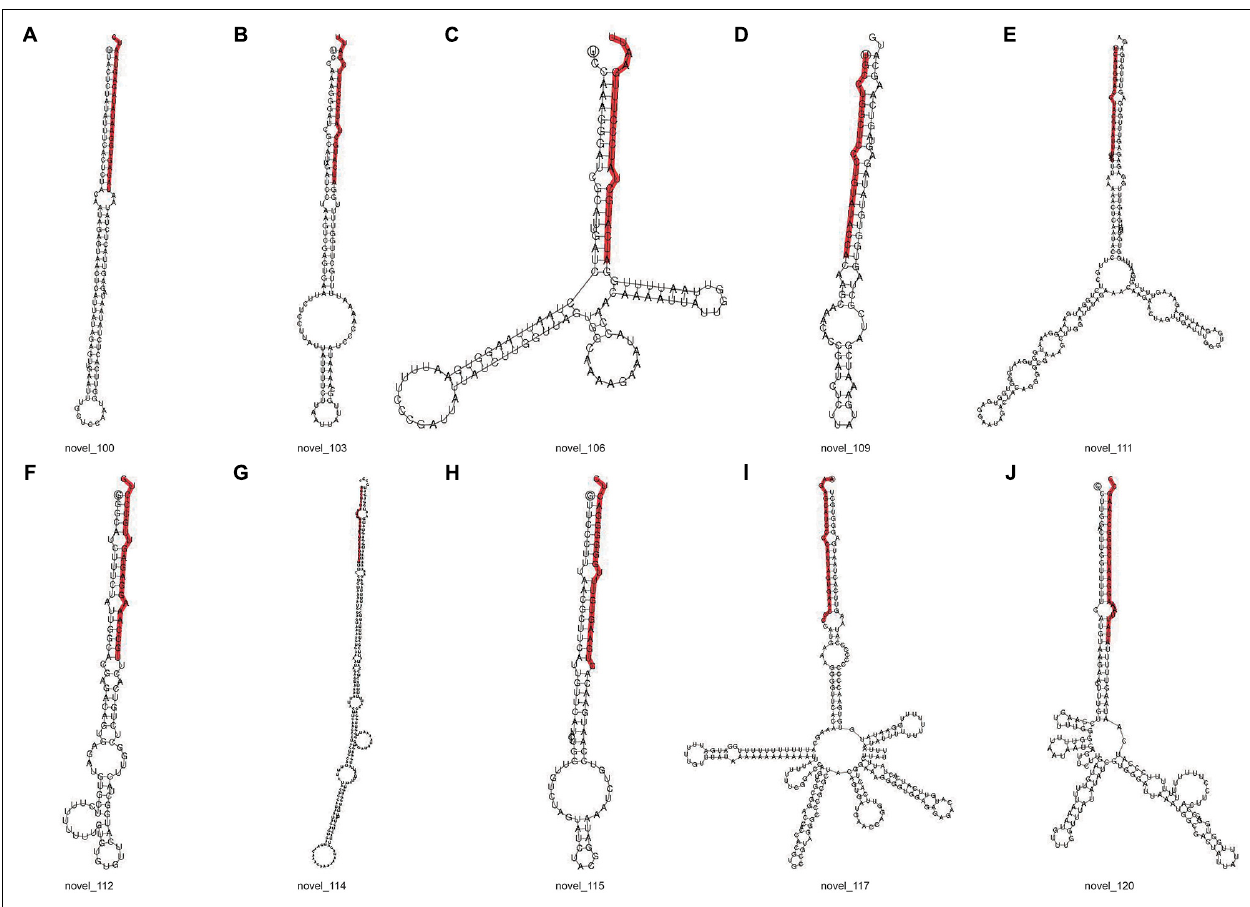
FIGURE 10 | Secondary structure of predicted new miRNA. (A–J) Secondary structure of 10 predicted new miRNA. The entire sequence is miRNA precursor, and the red highlight is where the mature sequence is located.